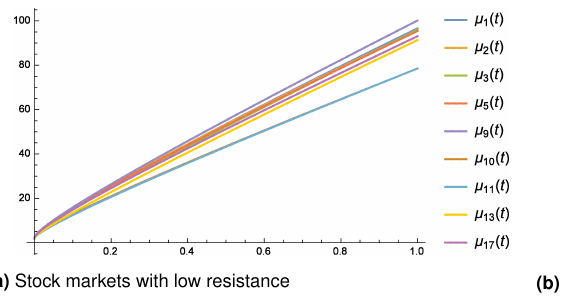
Fig. 8. The solution functions of the systems (12) with first 20